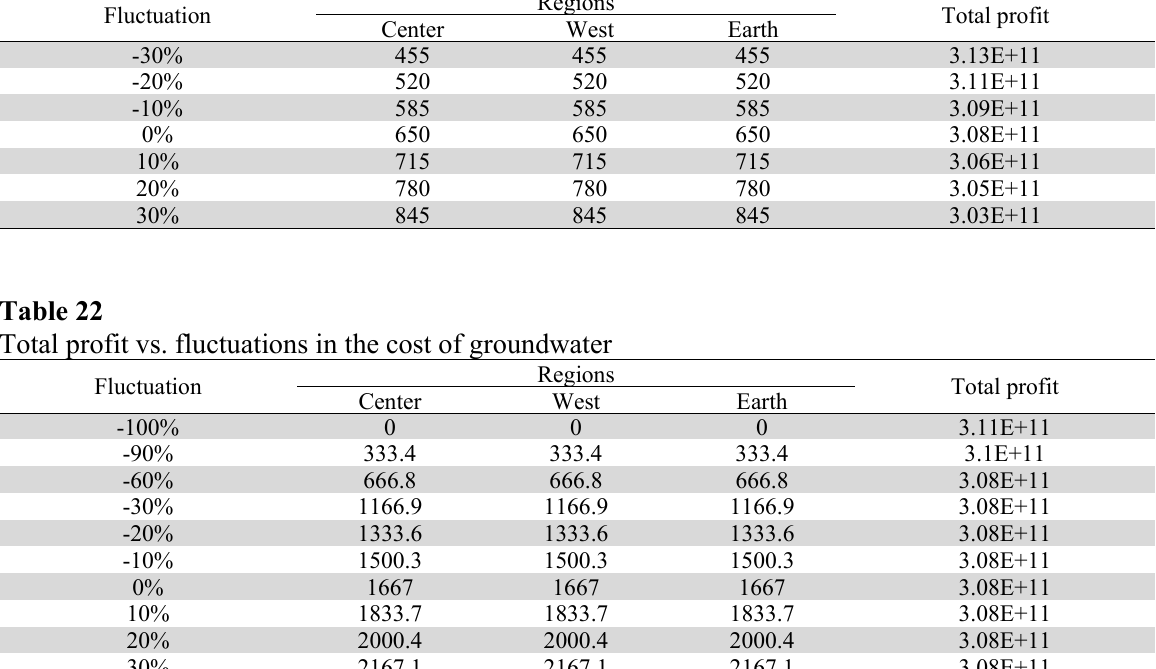
Total profit vs. fluctuations in the cost of surface water Fluctuation